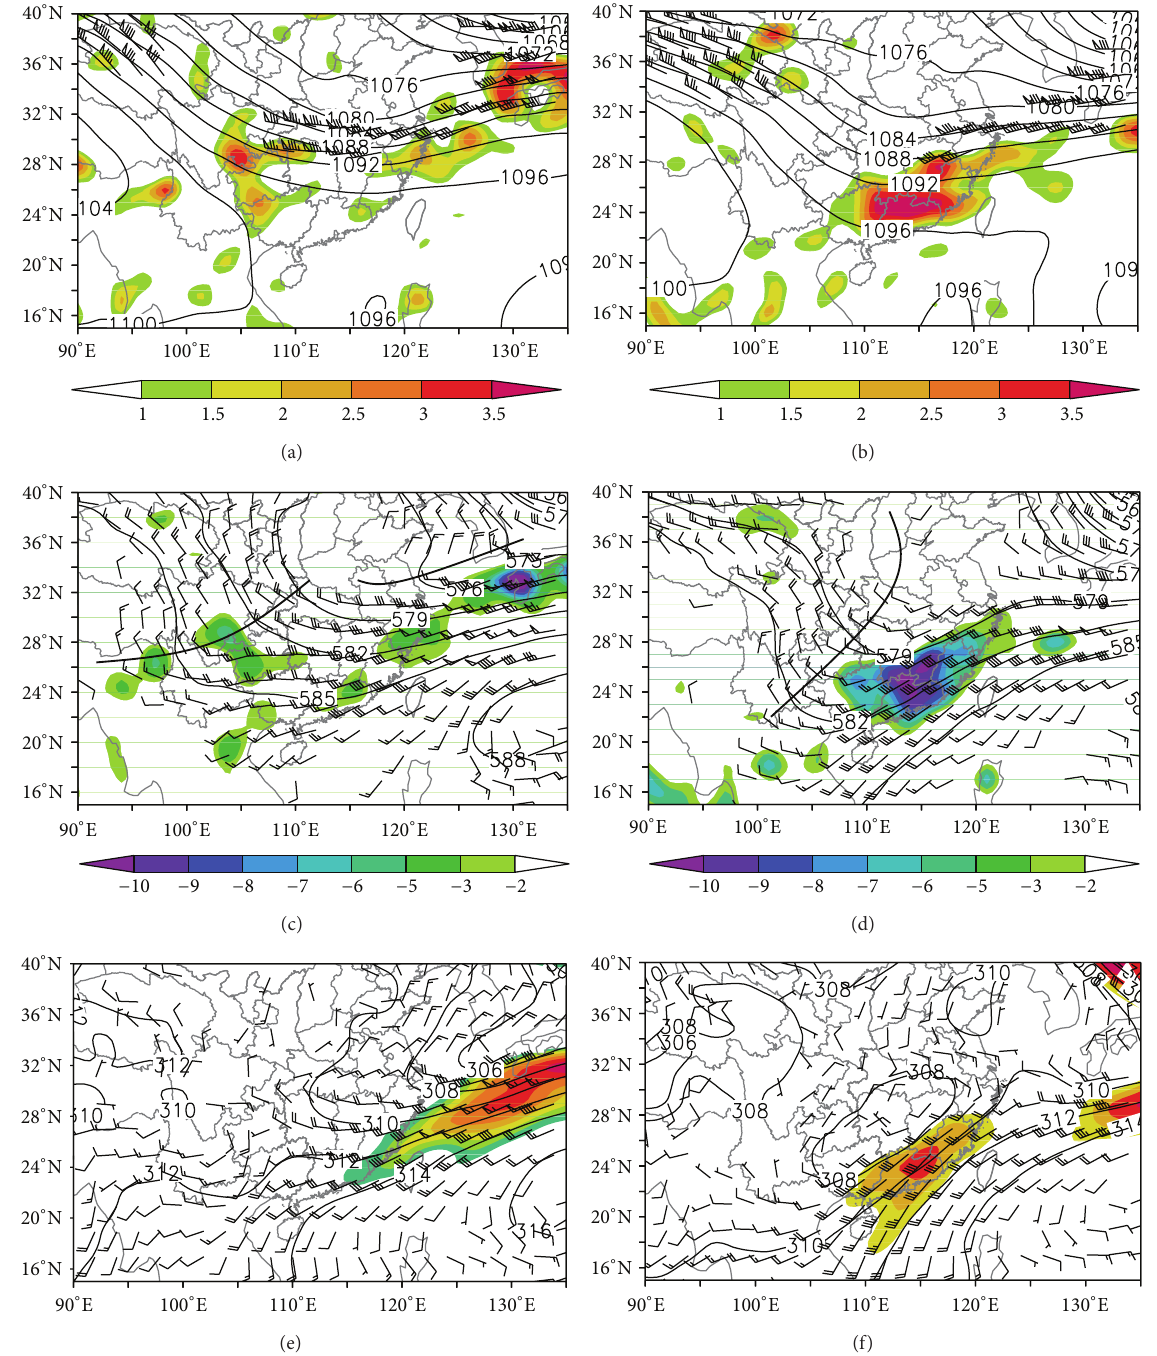
Figure 3: Wind and geopotential height fields at (a, b) 250 hPa, (c, d) 500 hPa, and (e, f) 700 hPa. (a), (c), and (e) are averaged from 18 UTC of June 10 to 18 UTC of June 11, 2008. (b), (d), and (f) are averaged from 18 UTC of June 11 to 18 UTC of June 13, 2008. The shaded areas indicate the divergence (10 −5 s −1 ) in (a) and (b), the vertical velocity (Pa/s) in (c) and (d), and the horizontal wind speed ( ≥ 12m/s) in (e) and (f).